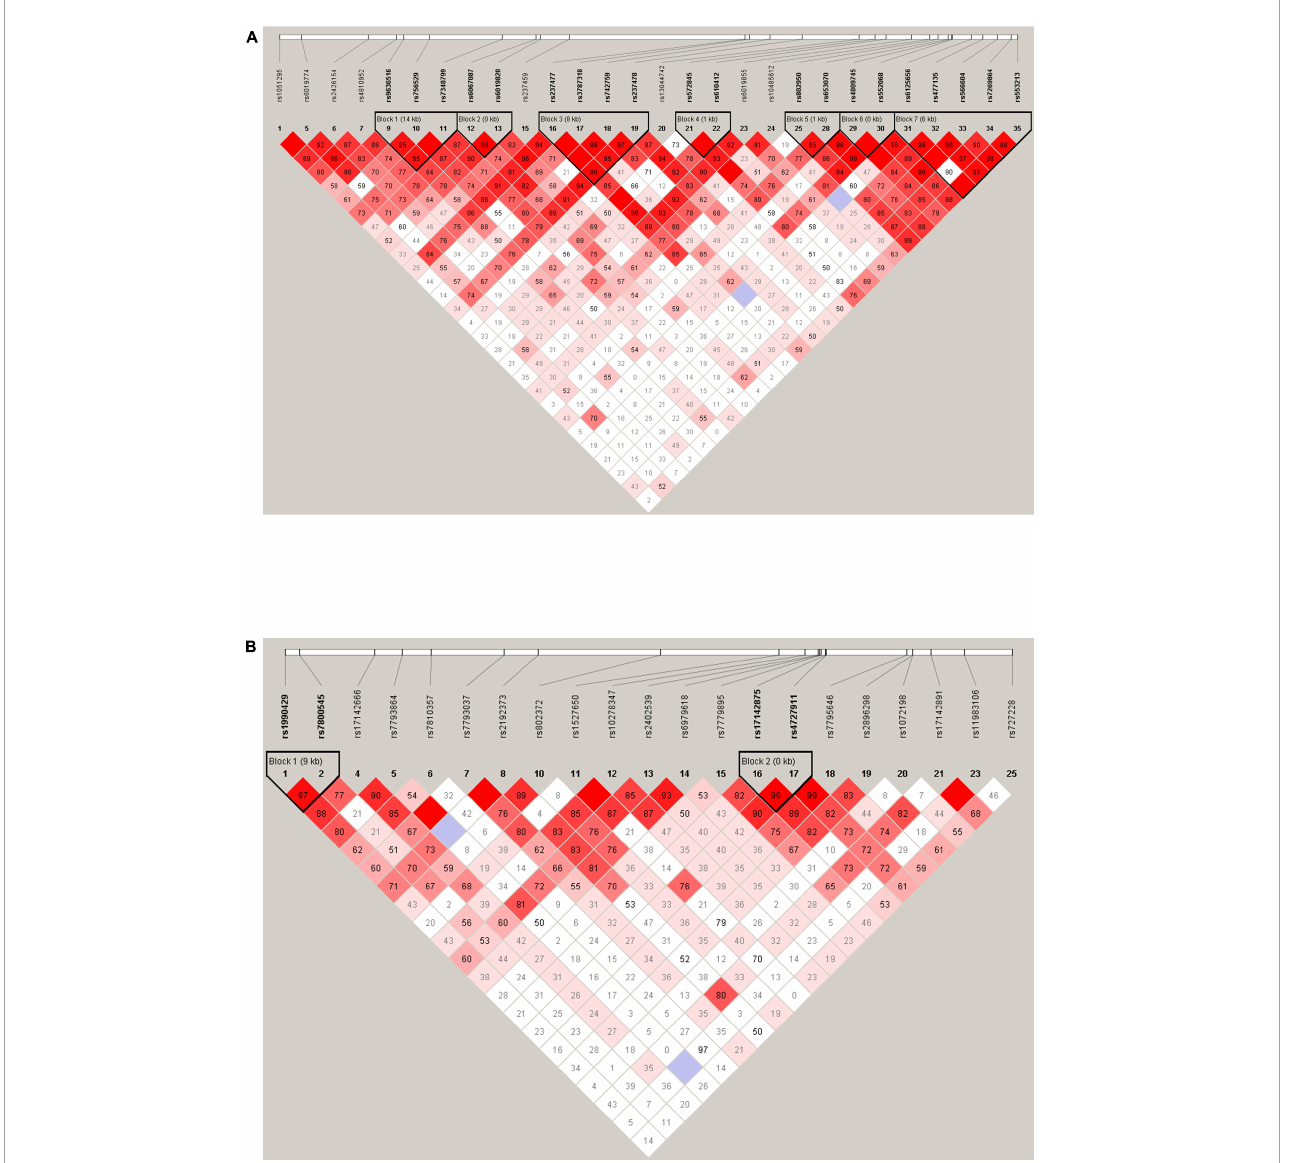
FIGURE1 Haplotype block map for 28 tag SNPs of the KCNB1 gene (A) . Haplotype block map for 21 tag SNPs of the KCND2 gene (B) . Numbers in squares indicate D’ values.